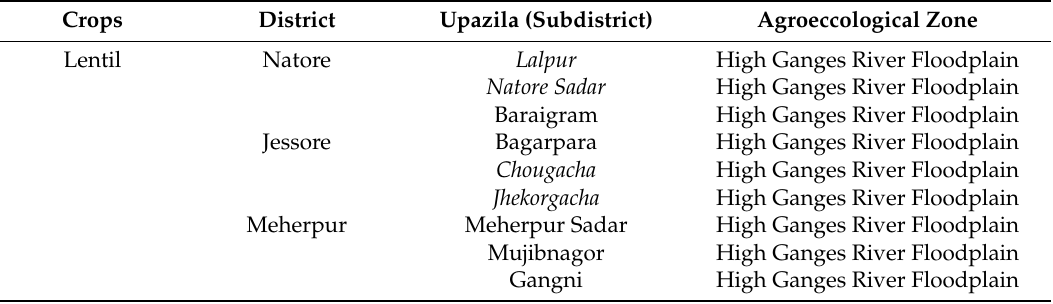
Table 1. Distribution of the samples by pulse type, regions and agroecological